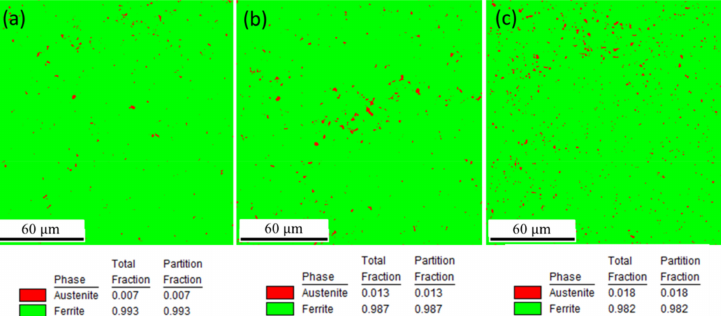
Figure 9. Phase composition of SLM low-alloy steel samples grown with di ff erent EADs: ( a ) EAD = 142 J / mm 2 ; ( b ) EAD = 71 J / mm 2 ; and ( c ) EAD = 47 J / mm 2 .